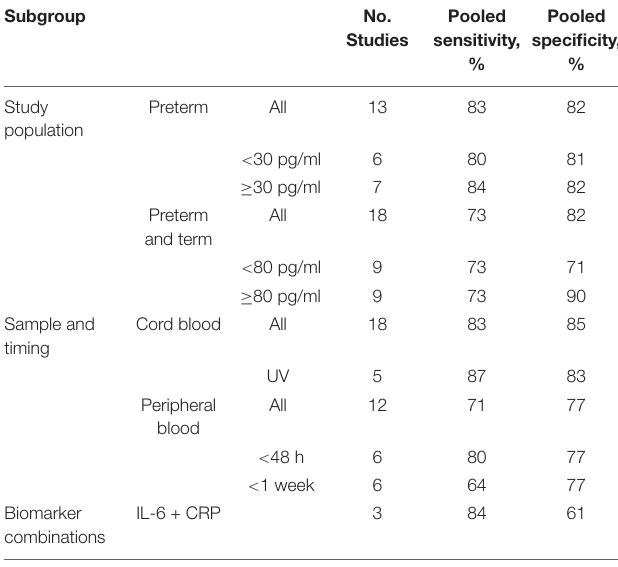
TABLE 4 | Subgroup analysis of IL-6 diagnostic accuracy studies on EONS. Subgroup No.